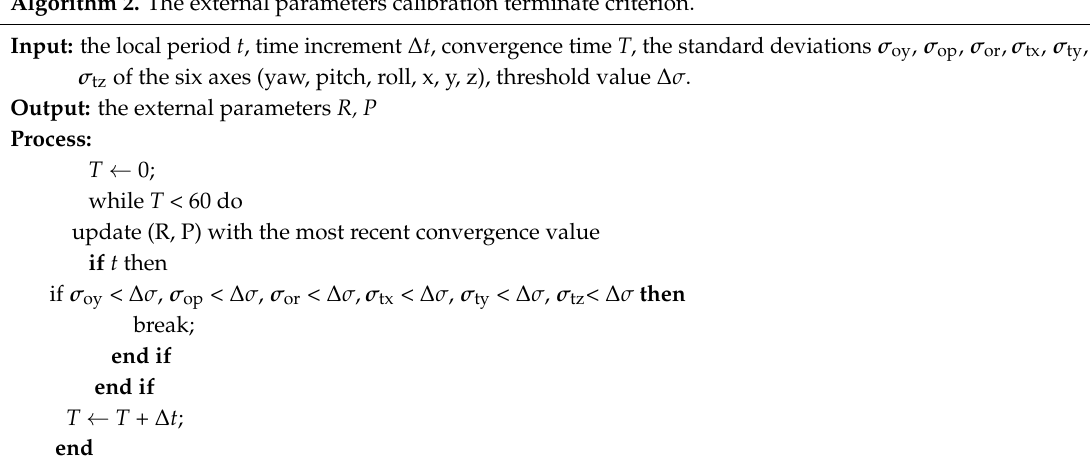
Algorithm 2. The external parameters calibration terminate